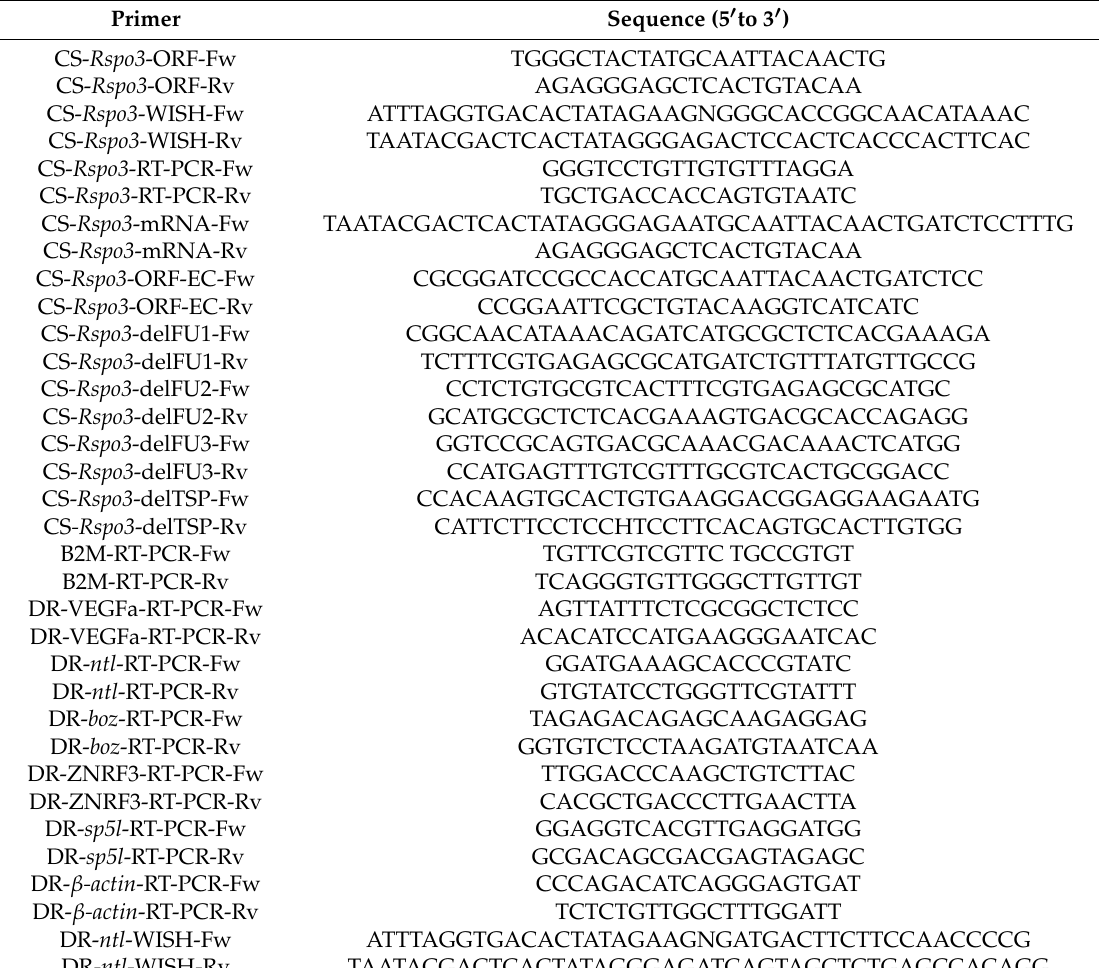
Table 1. Primers used in this